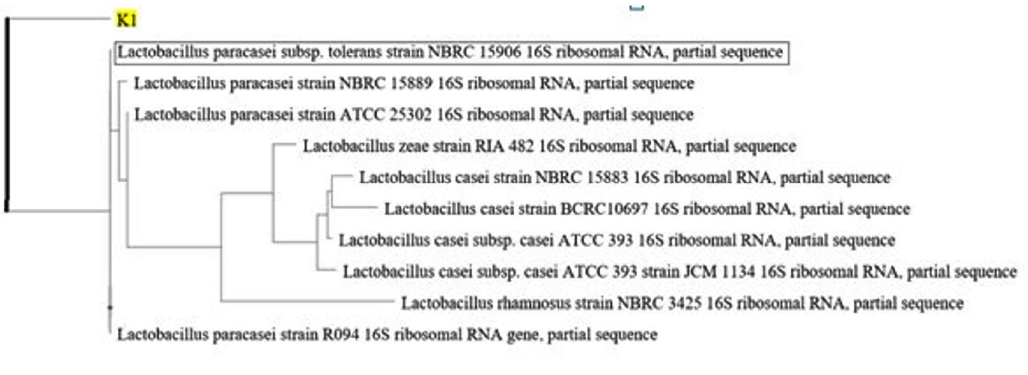
Fig. 2. Phylogenetic relationship of L. paracasei subsp. Tolerans K1 based on 16S rRNA sequencing